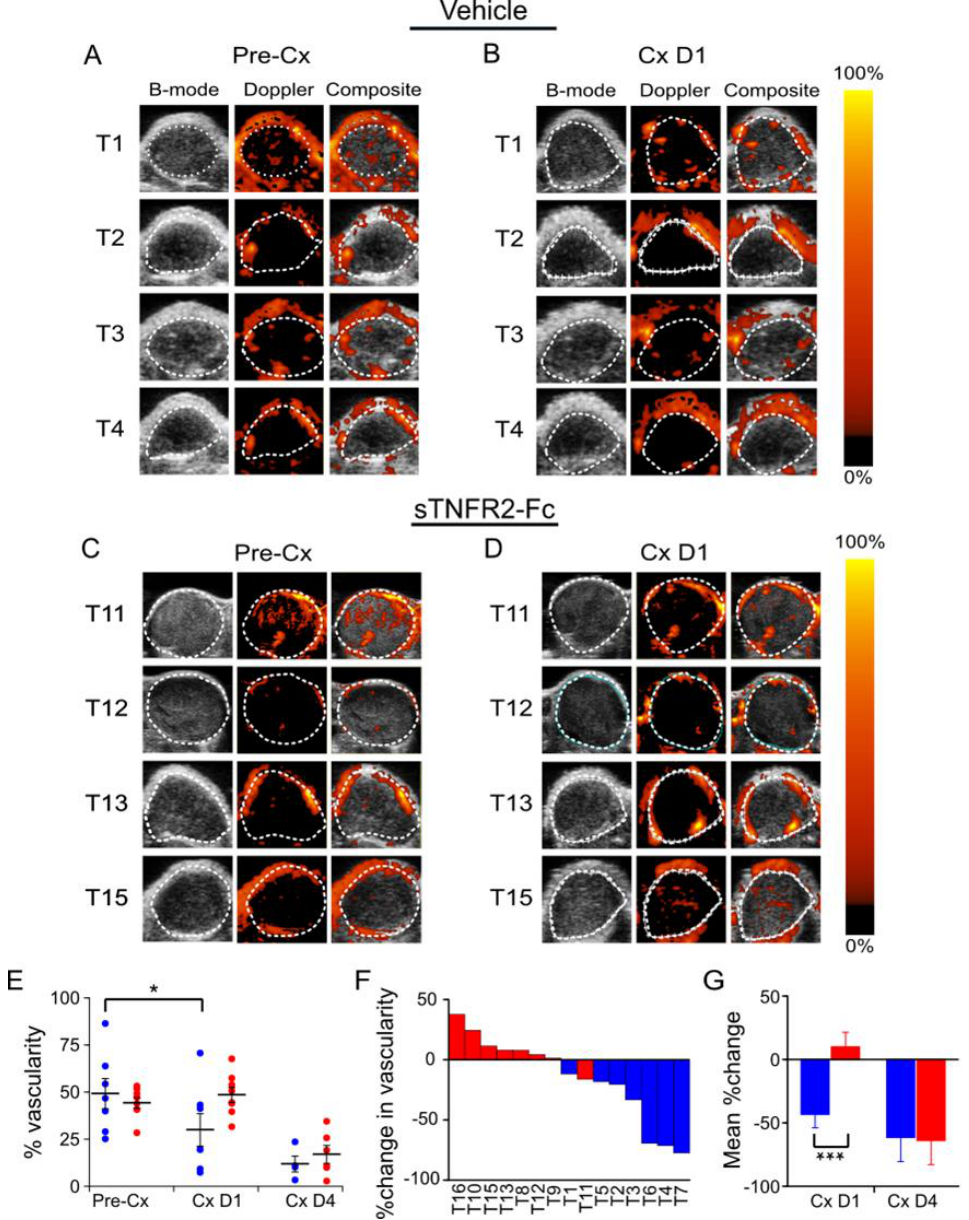
Figure 2. Castration-induced reduction of intratumoral blood flow in Myc-CaP tumor was dependent on TNF signaling. ( A ) Power Doppler (PD) images of subcutaneous Myc-CaP tumors pre-castration (Pre-Cx) of mice treated with PBS (Vehicle), tumors 1–4 (of 8 evaluable tumors). Left to right: Gray-scale ultrasound image (B-mode); PD pseudo-colored image to illustrate blood flow level (Doppler); Composite of PD image overlaid on the B-mode image (Composite). ( B ) PD images of tumors in panel A, one day after castration (Cx D1). ( C ) PD images of a second set of subcutaneous Myc-CaP tumors pre-castration of mice treated with sTNFR2-Fc, tumors 11, 12, 13, 15 (of 8 evaluable tumors). ( D ) PD images of tumors in panel C, one day after castration. ( E ) Mean PD signal (% vascularity, large bars) pre-castration, and at one and four days after castration from tumors in vehicle-treated (blue, D1 n = 8, D4 n = 7) and sTNFR2-Fc-treated mice (red, D1, D4 n = 8), PD signal of each tumor indicated by closed circles. ( F ) Waterfall plot of % change in vascularity in individual tumors at one day after castration. ( G ) Mean % change in paired measures of vascularity pre-castration versus D1 or D4 after castration. Columns and large bars are means and small bars are SEM. * p < 0.05, *** p <